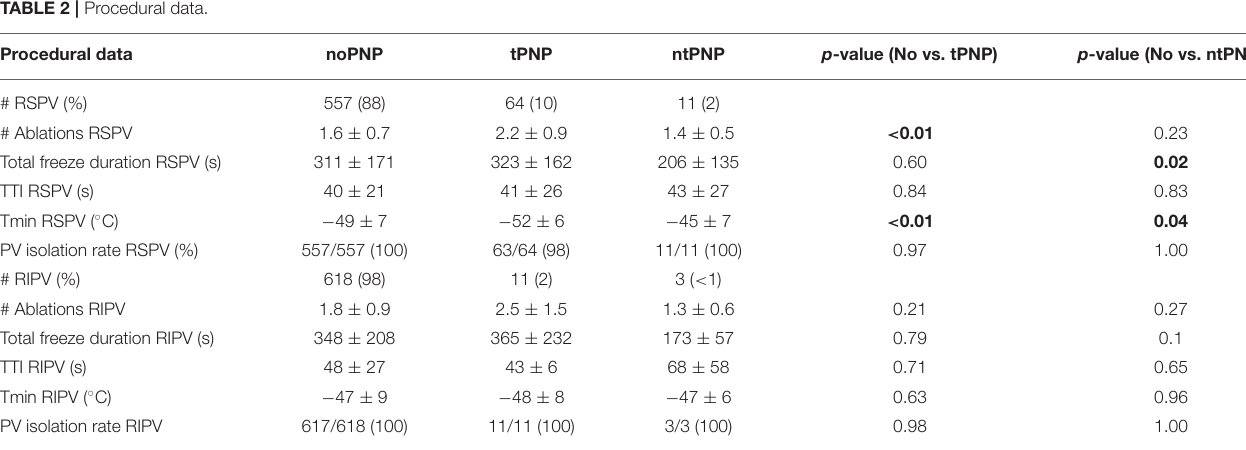
TABLE 2 | Procedural